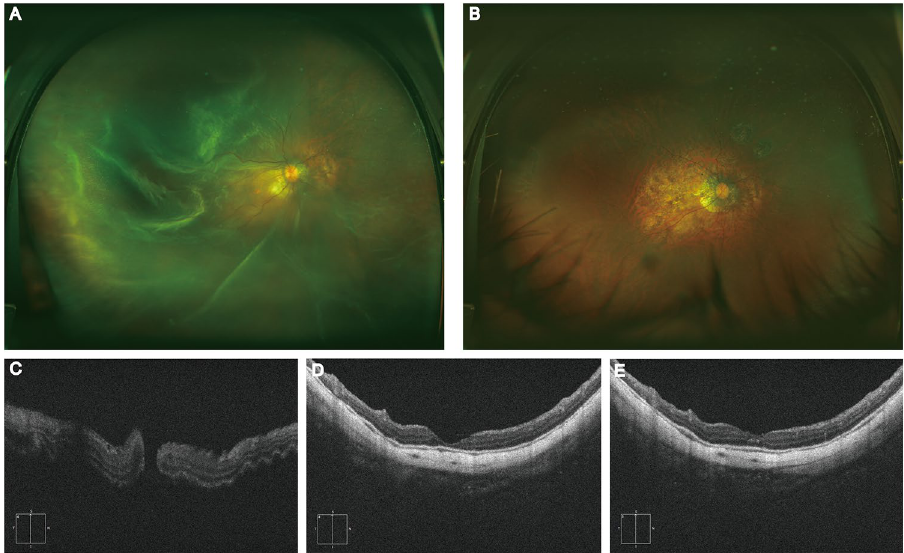
Figure 2. Representative images of inverted multi-layer ILM flap treating MHRD with choroidal detachment. Fundus color photos ( A – B ) and OCT images( C – E ) of this study in right eye of a patient in multi-layer ILM inversion group before and after operation. Before operation, fundus color photos show full-thickness macular hole retinal detachment with temporal peripheral choroidal detachment of the right eye ( A ), and the retina was reattached and the macular hole healed 3 months after operation ( B ); OCT images show retinal detachment in macular area and full-thickness macular hole shown by OCT before operation ( C ), and the macular hole was closed with no proliferation and the retina was reattached at one month ( D ) and three month ( E ) after operation.